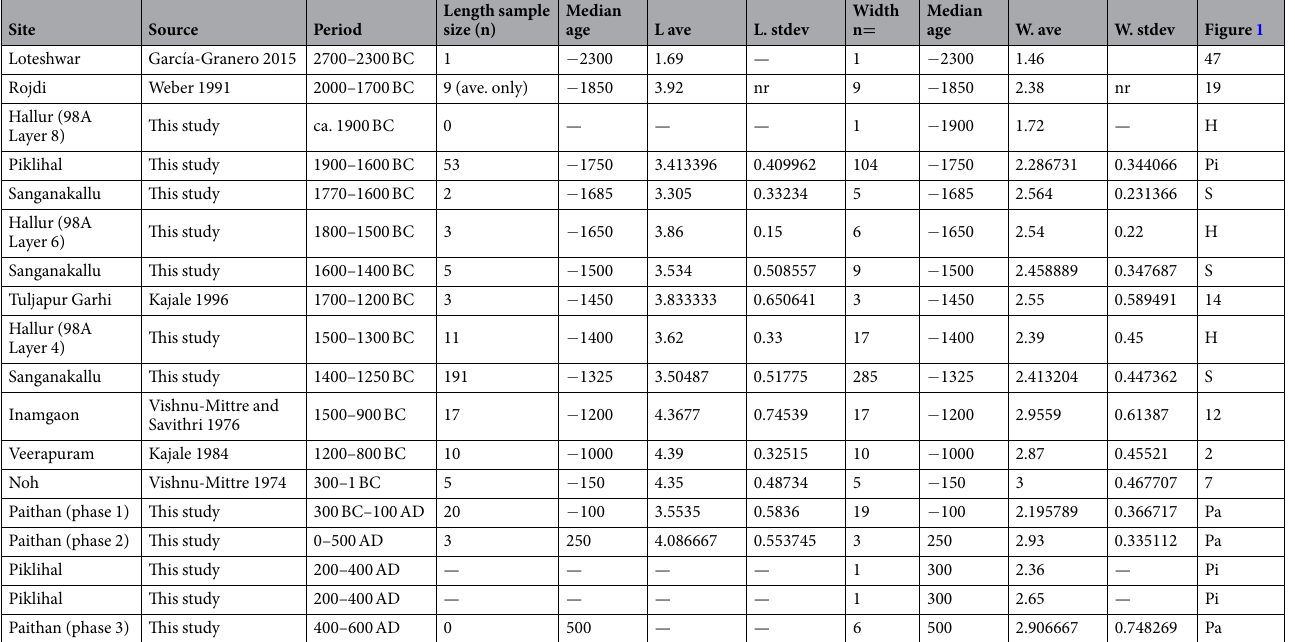
Table 1. Seed size measurements on assemblages of archaeological horsegram from various sites and archaeological phases, including seed length (L) and seed width (W) averages and standard deviation. Seed measurements from this study are provided raw in Table S6. Median age is based upon currently accepted archaeological and radiocarbon information at time of publication 49–53 .